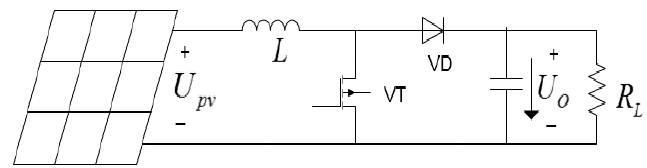
Figure 4. Boost increment circuit in the PV charging module.